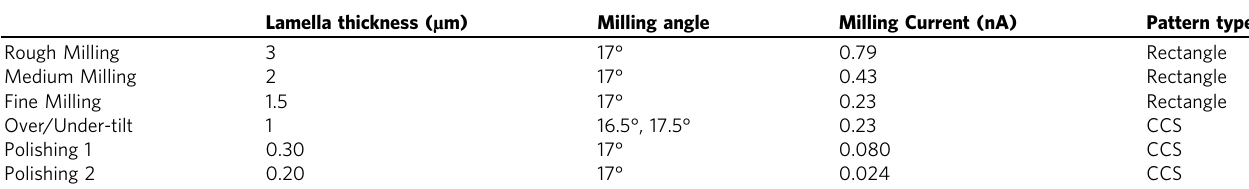
Table 1 Manual FIB-milling and thinning parameters on the Helios